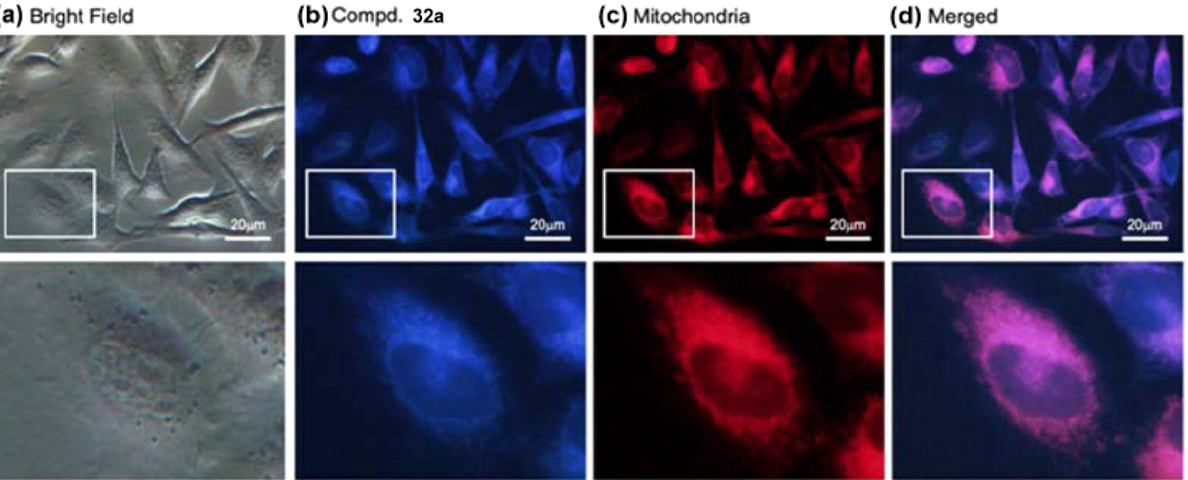
Figure 26. Confocal fluorescence images of mitochondria in HeLa cells stained with 32a and mitochondrial marker. ( a ) Bright field image, ( b ) blue florescence of 32a , ( c ) red fluorescence of mitochondrial marker, and ( d ) merged images. Adapted from [69].